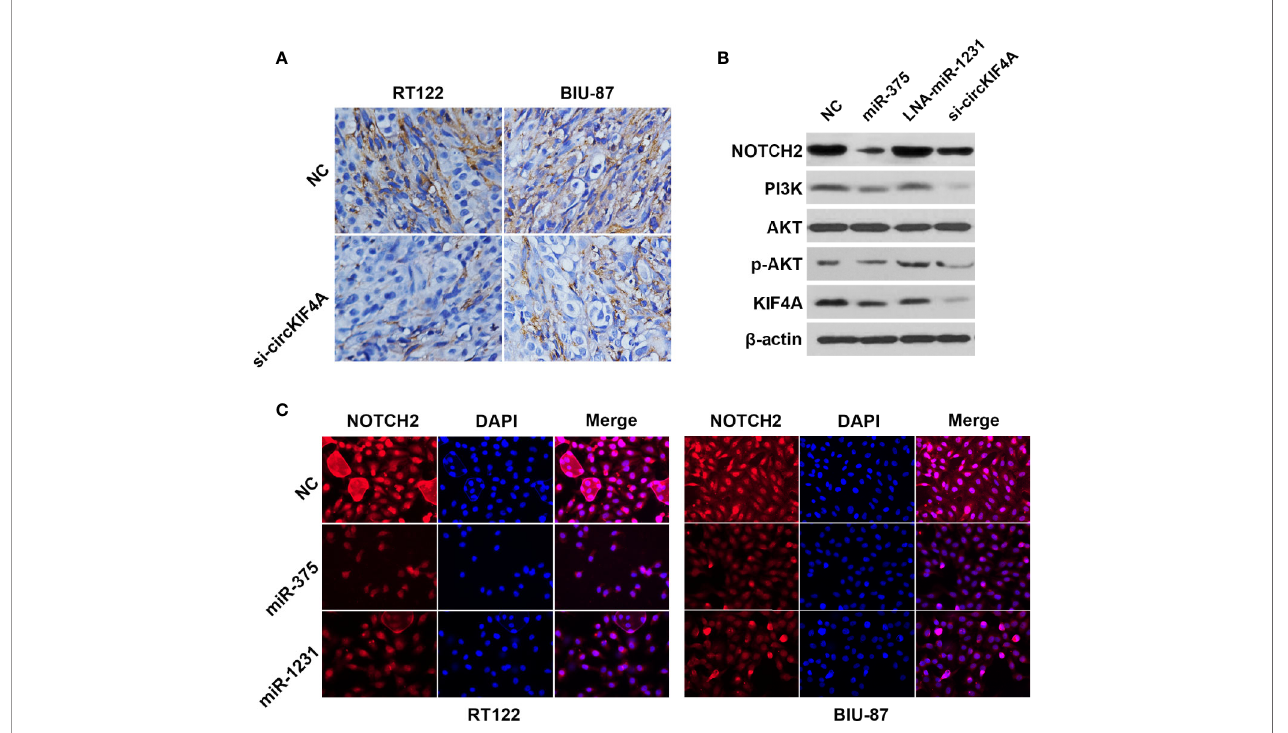
FIGURE 5 | circKIF4A promotes bladder cancer progression via the circKIF4A-miR-375/1231-NOTCH2 axis. (A) Representative immunohistochemistry images of NOTCH2 expression in a mouse xenograft model. (B) Western blot analysis was conducted to evaluate the in fl uence of miR-375, miR-1231 and circKIF4A on NOTCH2, the PI3K-AKT signaling pathway and KIF4A in the RT-112 cell line. (C) Immuno fl uorescence staining of NOTCH2 after transfection with miR-375 or miR- 1231 mimics in RT-112 and BIU-87